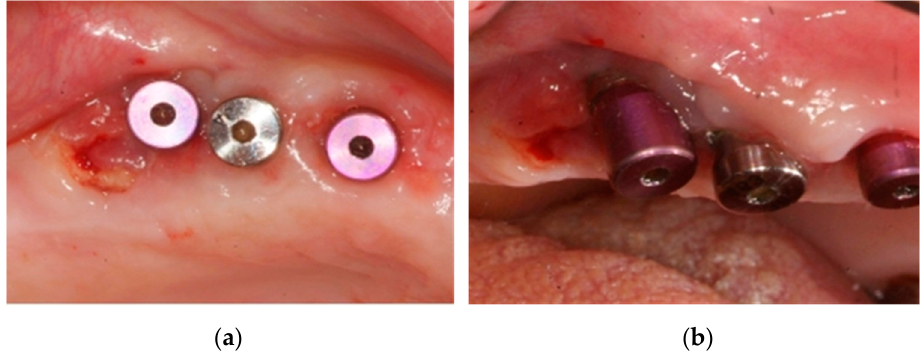
Figure 9. ( a , b ) Clinical situation at 45 days after removal of necrotic bone tissue and antibiotic therapy.